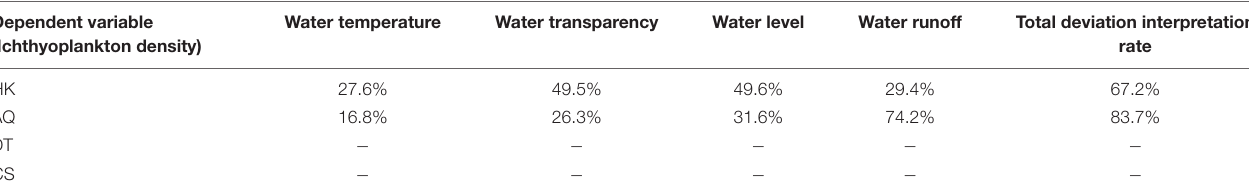
FIGURE 4 | GAM analyses for fish larvae in the HK and AQ sections. The ordinate s() indicates the non-parametric smoothing term, and the abscissa indicates the parameter value. The solid line indicates the regression curve obtained by automatically determining the smoothing parameters, and the dotted line represents the possible variation range of the regression curve. TABLE 3 | Deviation interpretation rate of environmental factors for the GAM